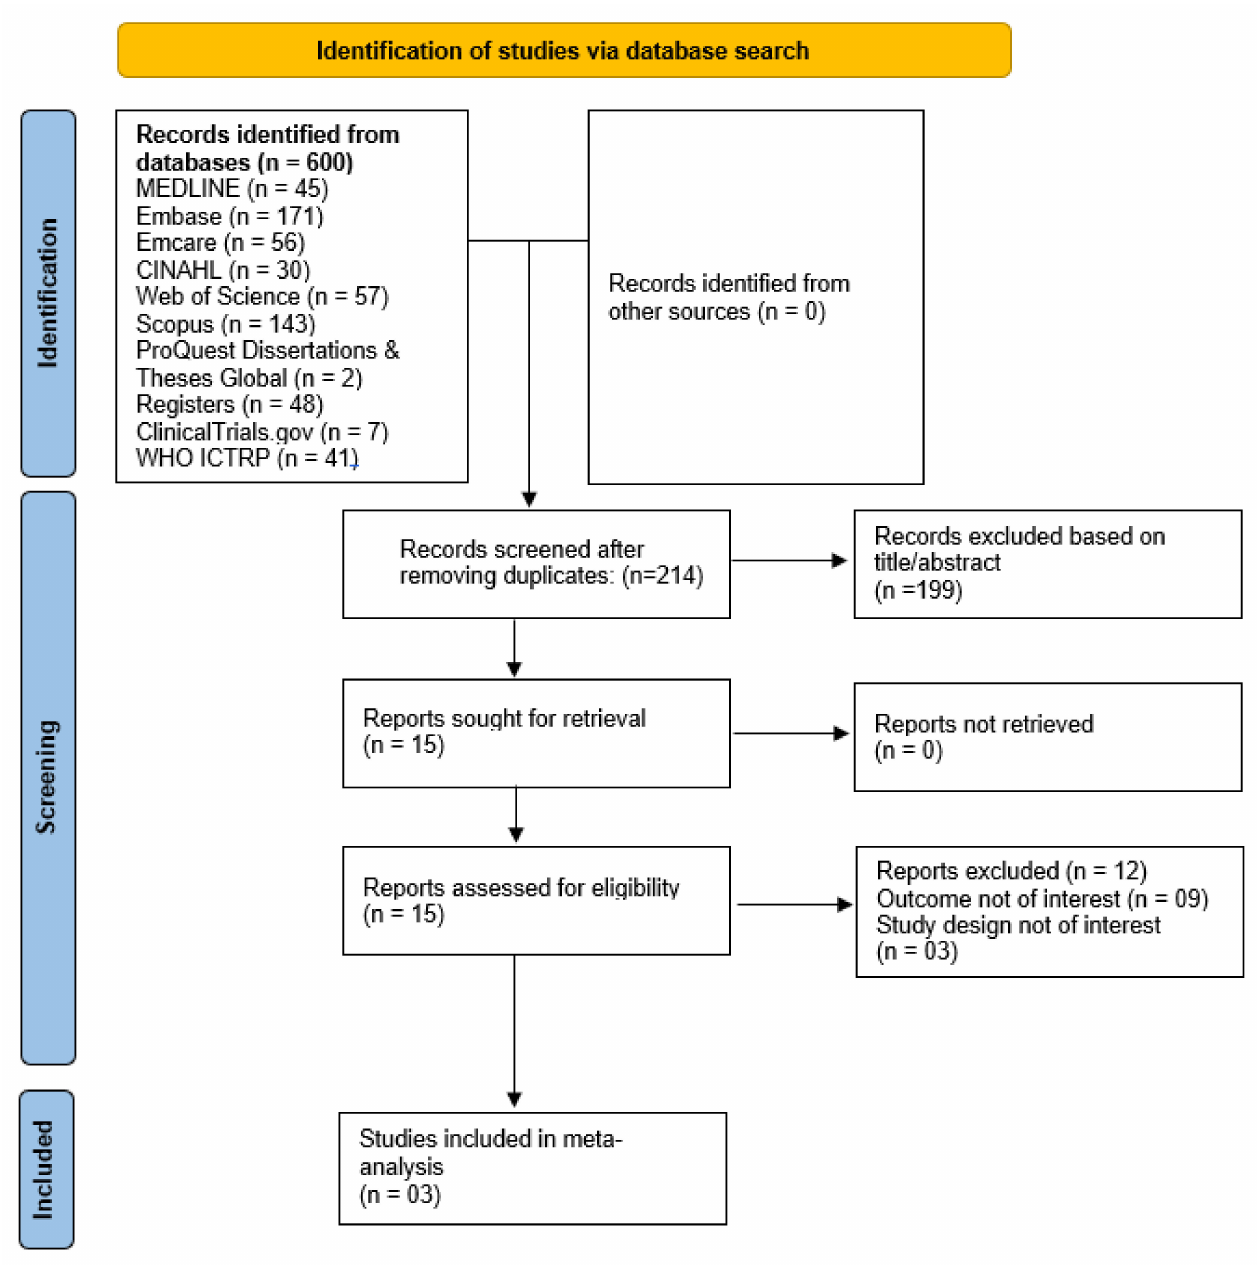
Figure 1. PRISMA flowchart showing the study inclusion process. The subgroup analysis revealed a statistically significantly higher risk of preeclamp- sia in pregnant women receiving PPIs in each of the three trimesters (Figure 2b). All the analyses were adjusted for maternal age, chronic kidney disease, autoimmune dis- ease, multiple gestation, pregestational diabetes, chronic hypertension, nulliparity, and multiple